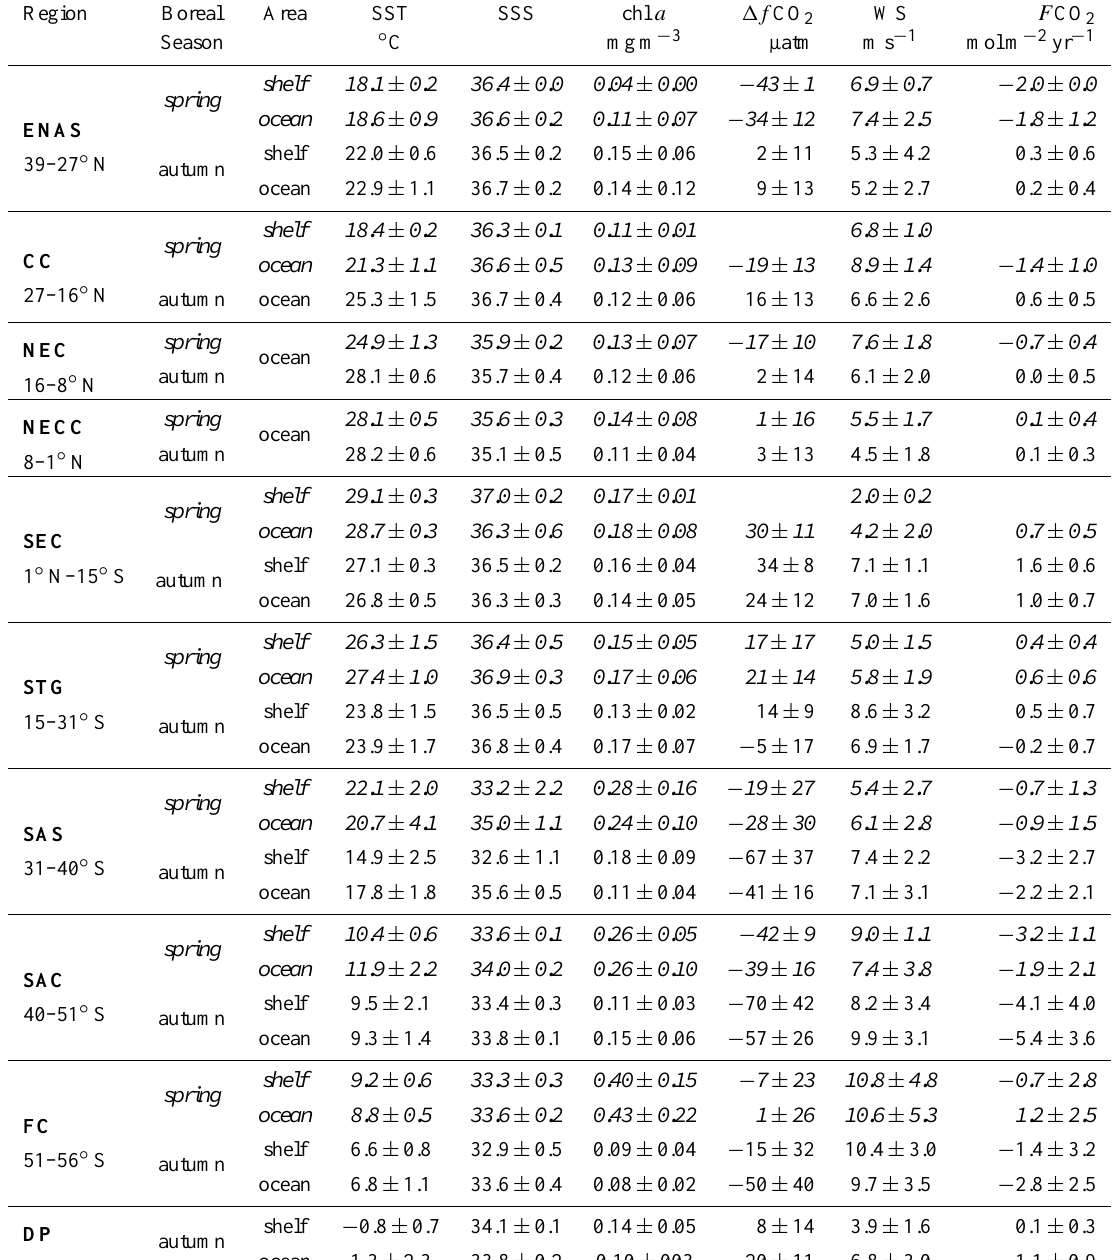
Table 2. Statistics for the selected provinces on the different boreal seasons (spring; autumn) and areas (shelf; ocean): Mean and standard deviation ( µ ± σ) of SST, SSS, chl a , 1f CO 2 , WS, F CO 2